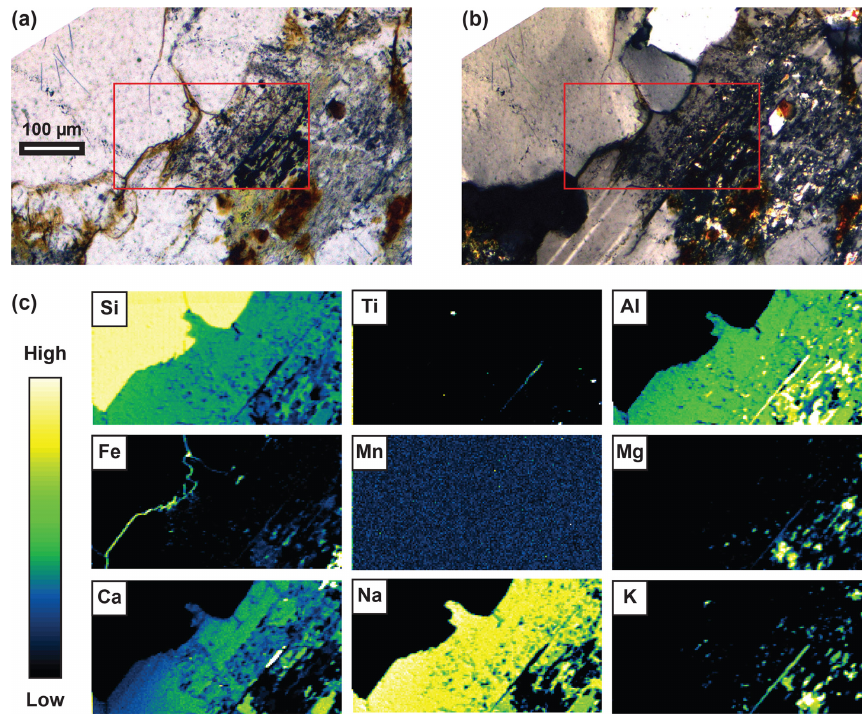
Figure 9. Microphotographs and elemental maps showing the Fe-rich material filling fractures in the pink granite. (a) polarized light, (b) cross-polarized light, (c) elemental maps for the region delimited by the red rectangle in (a) and (b)